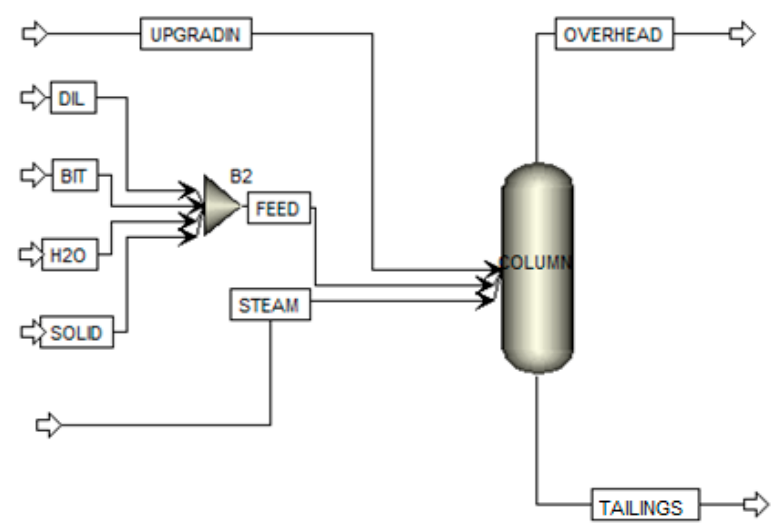
Figure 10. Configuration of the RadFrac model of the NRU column.